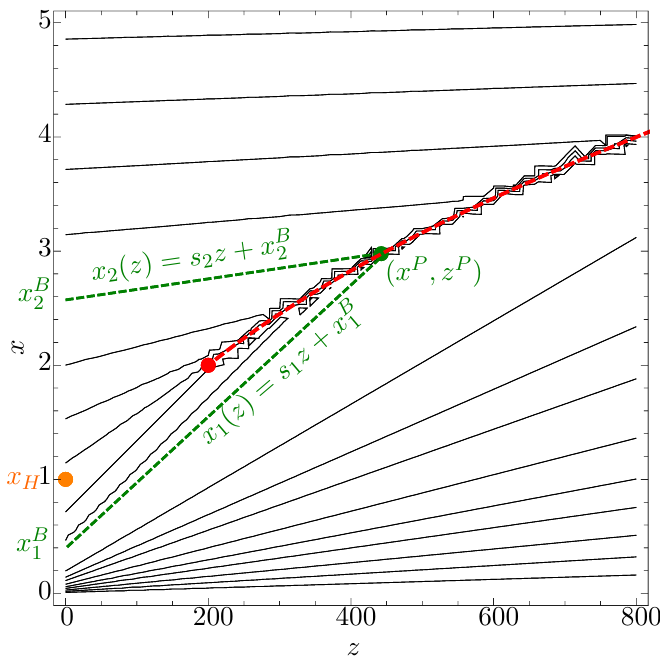
Figure 9 . This (cid:12)gure is essentially a reproduction of the (cid:12)gure in the top right corner of (cid:12)gure 3, which depicts the situation for t bdy ( x ) = (cid:0) 0 : 01 . The lines are projections of the null rays forming 1+ x 2 the lightfront down to the x; z -plane, and should hence be perfectly straight. Any deviation from straight line behaviour is due to numerical inaccuracies. The red point is the caustic and the orange point is the hyperbolic point, both as de(cid:12)ned in section B.2. The change compared to (cid:12)gure 3 is that we have plotted fewer lightrays overall, and highlighted two speci(cid:12)c lightrays emanating from the boundary points x B and x B as green dashed lines. These two lightrays meet at the same point 1 2 with coordinates ( x P ; z P ) of the null-null